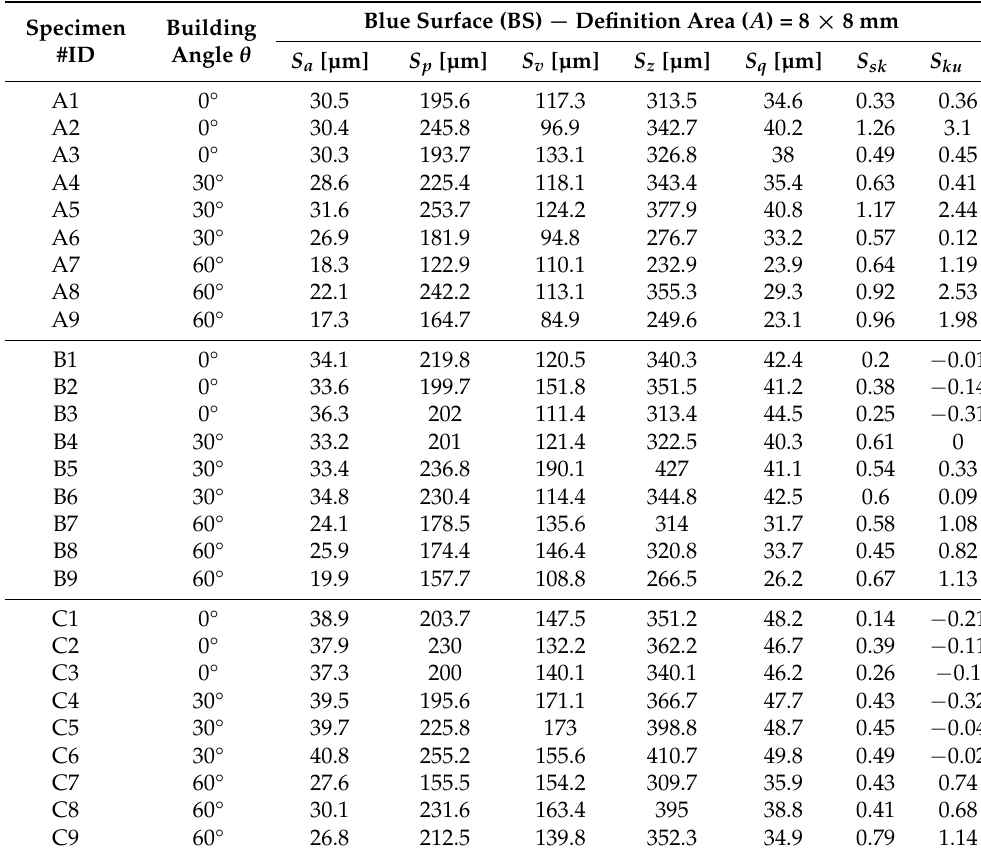
Table 7. Surface texture parameters results: BS with a definition area ( A ) = 8 × 8